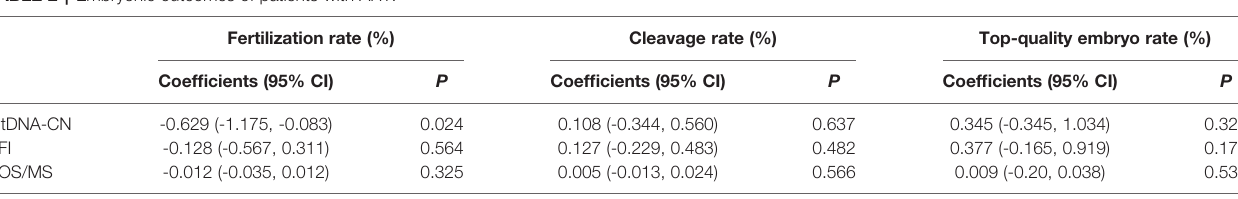
FIGURE 1 | Associations of mtDNA-CN, DFI, ROS, and male age with seminal quality. mtDNA-CN, mitochondrial DNA copy number; ROS, reactive oxygen species; DFI, DNA fragmentation index; OR, odds ratio; CI, con fi dence interval. TABLE 2 | Embryonic outcomes of patients with ART.